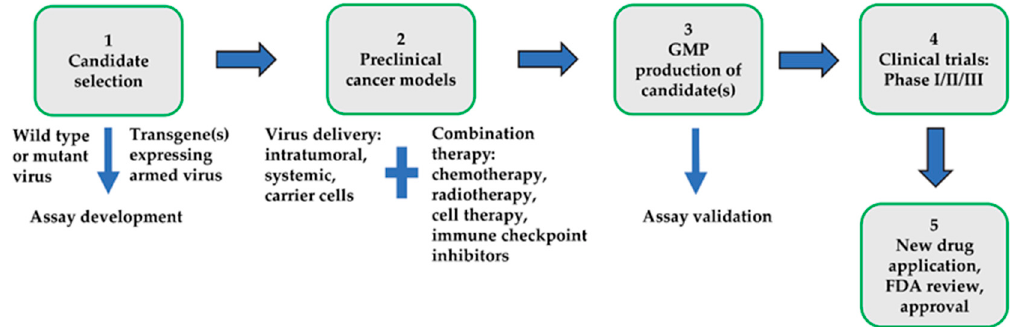
Figure 1. The clinical developmental path for the oncolytic virus. Multiple steps are involved in the selection, testing and development of an oncolytic virus candidate that can be successfully used in the clinic for cancer treatment.